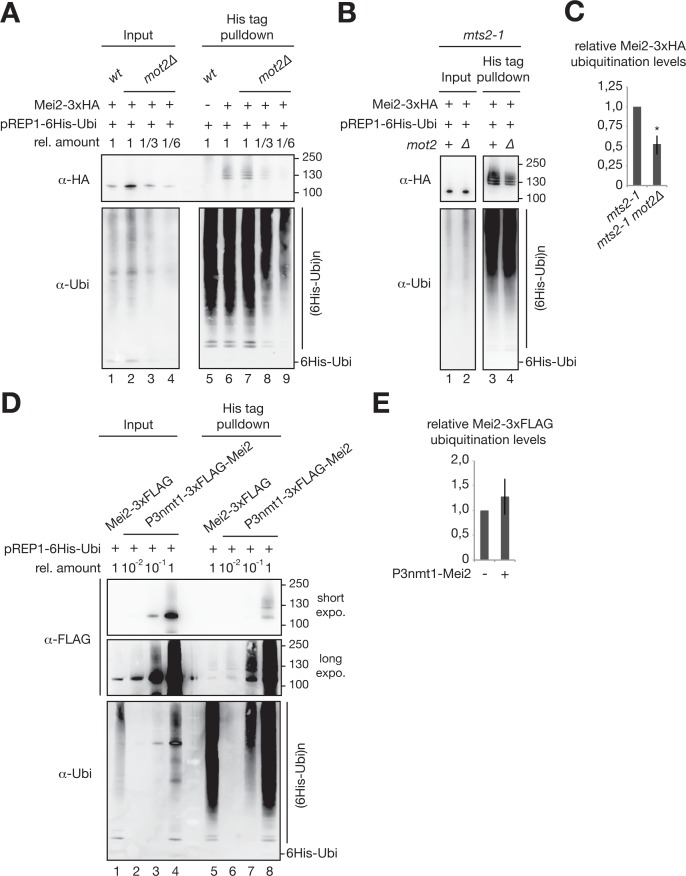
Contribution of Mot2 to the ubiquitination of Mei2.(A) In vivo ubiquitination of Mei2-3xHA in wt and mot2∆ cells as described in Figure 6B. Samples of the mot2∆ mutant were serial diluted to estimate the levels of ubiquitinated Mei2 species when similar amounts of total Mei2 are used from the two strains. (B) In vivo ubiquitination of Mei2-3xHA as described in Figure 6B but in mts2-1 and mts2-1 mot2∆ cells grown in EMM-LEU0.5X at 28°C before a temperature shift at 37°C for 1 hr. (C) Quantification of Mei2 ubiquitinated species relative to total protein levels and expressed relative to mts2-1 cells. Error bars represent the standard deviation from three independent experiments. Stars denote statistical significance relative to the mts2-1 Mei2-3xHA strain (t-test p-value=1.89E-2). (D) In vivo ubiquitination of 3xFLAG-tagged Mei2 as described in Figure 6B but in cells expressing endogenous levels of the protein (e.g. Mei2-3xFLAG) or overexpressing it (e.g. P3nmt1-3xFLAG-Mei2). Total and ubiquitinated Mei2, as well as ubiquitin conjugates were analyzed using anti-FLAG and anti-ubiquitin antibodies respectively. Shown are short and long exposures for the anti-FLAG immunoblotting. (E) Quantification of Mei2 ubiquitinated species relative to total protein levels and expressed relative to Mei2-3xFLAG wild type cells. Error bars represent the deviation from the mean of biological duplicates.